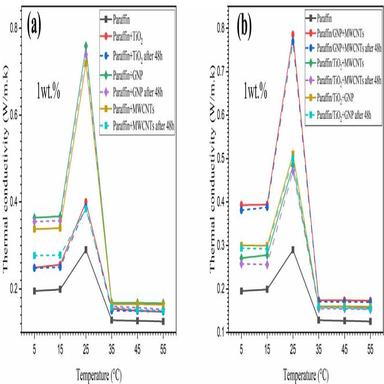
Thermal conductivities versus temperature of nano phase PCMs after 48 h (a) single, and (b) hybrid nano-enhanced phase change materials for thermal conductivity after 48 h.